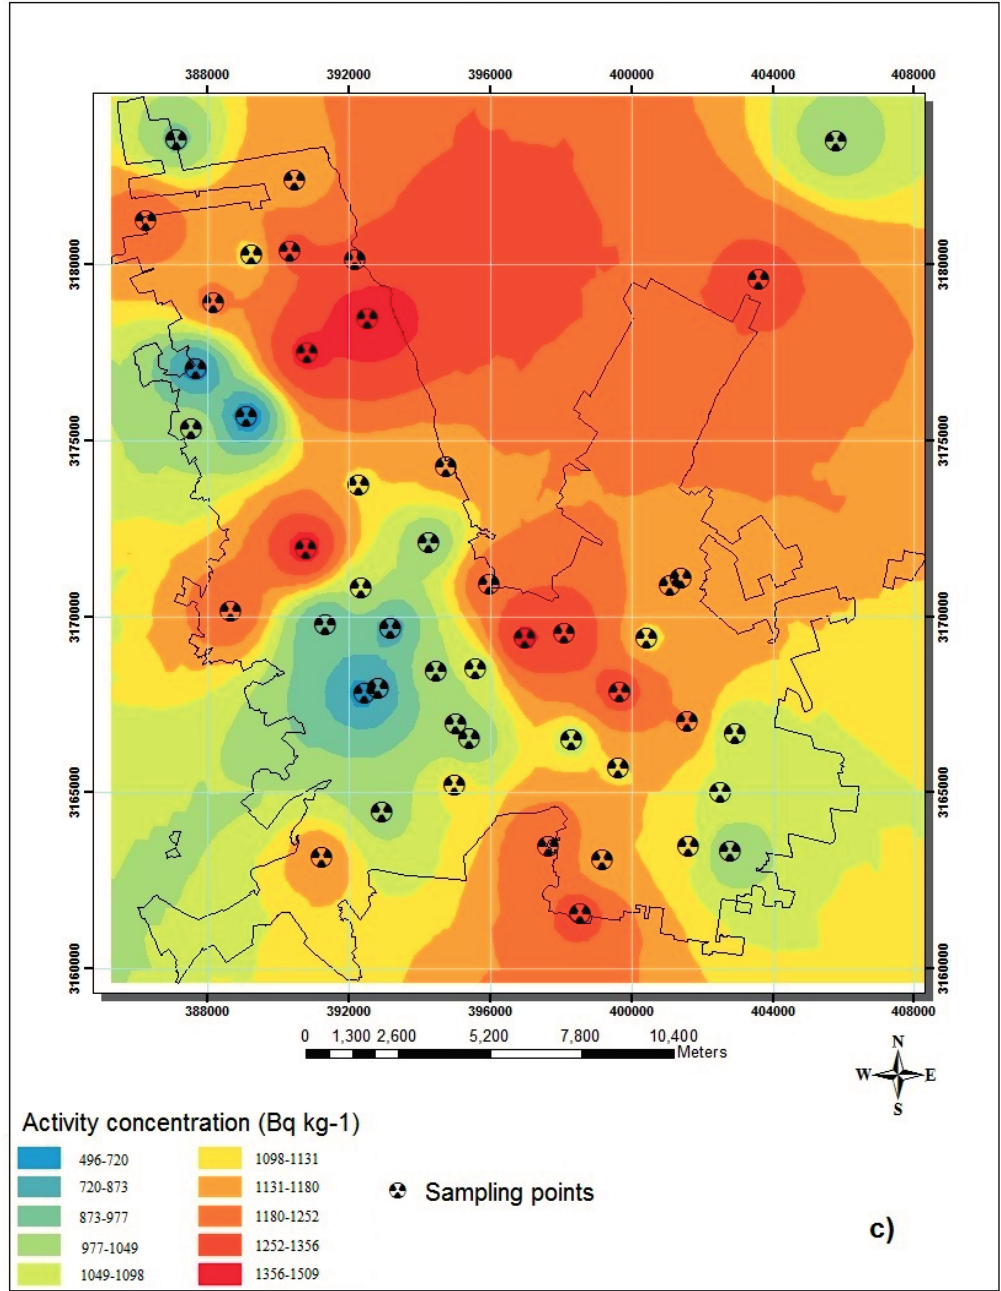
Figure 3. Spatial distribution of the radioisotope activity concentration found in soil: ( a ) 226 Ra; ( b ) 232 Th; and ( c ) 40